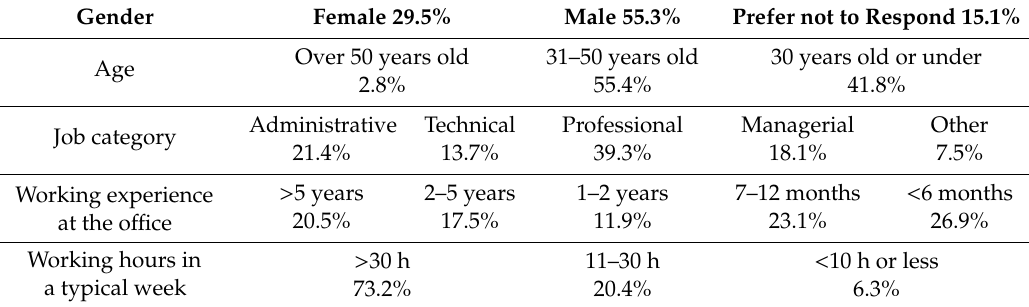
(o ffi ce workers’) profiles are summarized in Table 3. The data were analyzed using statistical methods, with the use of SPSS version 24. Table 3. Summary of occupant profiles in focused groups (10 lowest-performing o ffi ces (LPO) and 10 highest-performing o ffi ces